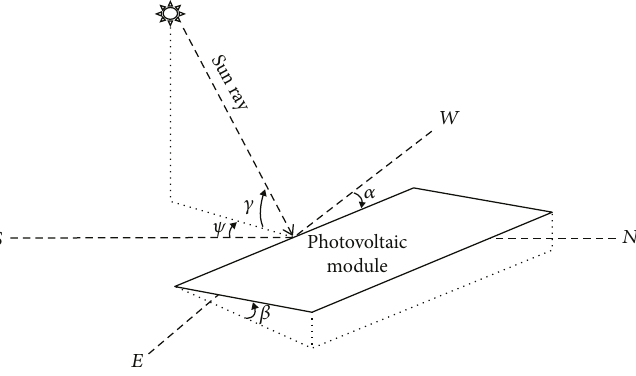
Figure 2: Angles that de fi ne the position of the PV arrays and the sun